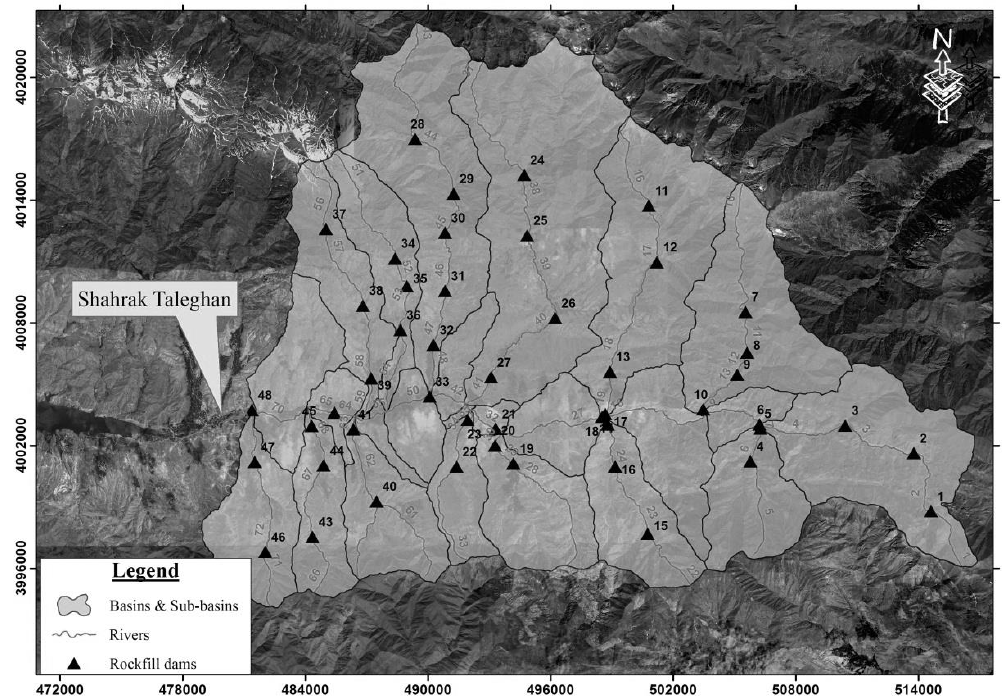
Figure 2 . Study reaches with locating of rockfill dams and downstream residential area Flood routing at the